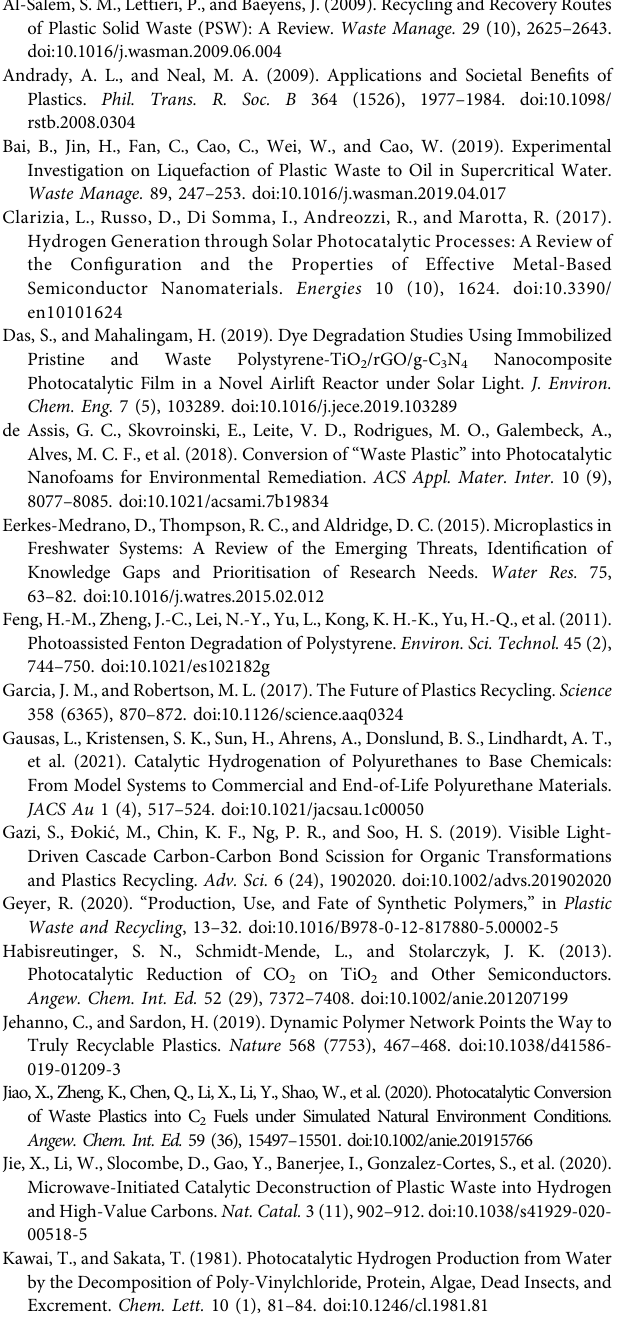
environment conditions; (B) atomic force microscopy image of Nb 2 O 5 ; (C) the yield ofCO 2 during the photoconversion ofpure PE, PP,and PVC over the Nb 2 O 5 atomic layers; (D) the yield of CH 3 COOH under the simulated solar light; (E) schematic representations for the band-edge positions of Nb 2 O 5 atomic layers along with the potentialsofCO 2 ,H 2 O,H 2 O 2 ,andO 2 redoxcouplesatpH7andtheproposedtwo- step C-C bond cleavage and coupling mechanism from pure PE into CH 3